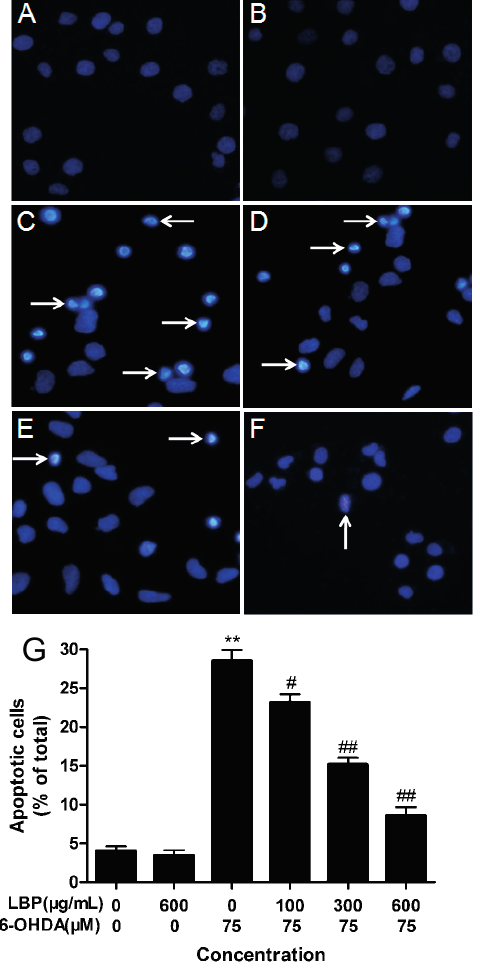
Figure 2. LBP rescues 6-OHDA-induced changes in nuclear morphology. Nuclear morphology was assessed using DAPI staining. ( A ) shows normal culture medium nucleic morphology, ( B , C ) respectively show cells cultured in 600 μ g/mL LBP or 75 μ M 6-OHDA for 24 h. In addition, cells were pretreated with 100 μ g/mL ( D ), 300 μ g/mL ( E ) or 600 μ g/mL ( F ) LBP for 24 h and then incubated in 6-OHDA (75 μ M) for an additional 24 h. ( G ) Histograms showing ratio of condensed nuclei to total nuclei. ( ** p < 0.01 compared with untreated control cells; # p < 0.05, ## p < 0.01 compared with 6-OHDA-treated cells). White arrows represent location of apoptosis cell. Scale bars represent 50